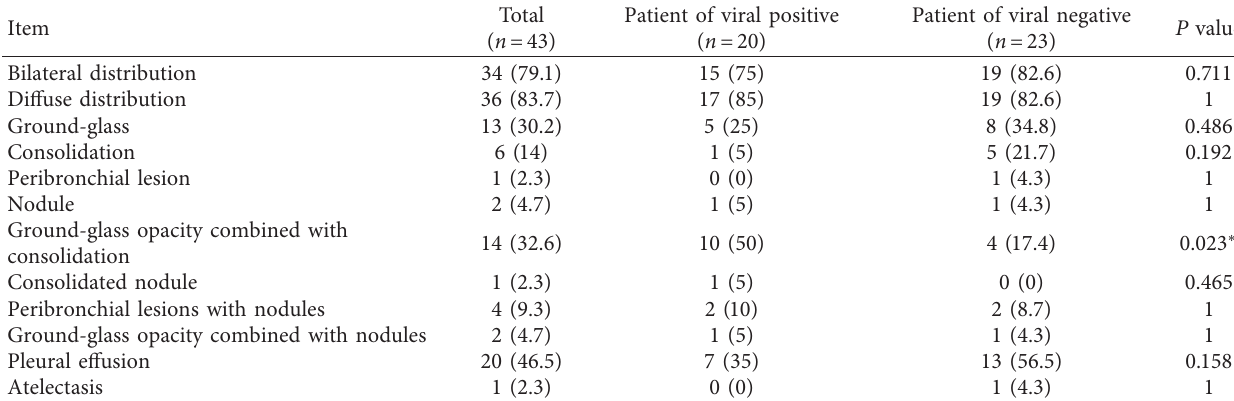
Table 4: Pulmonary CT